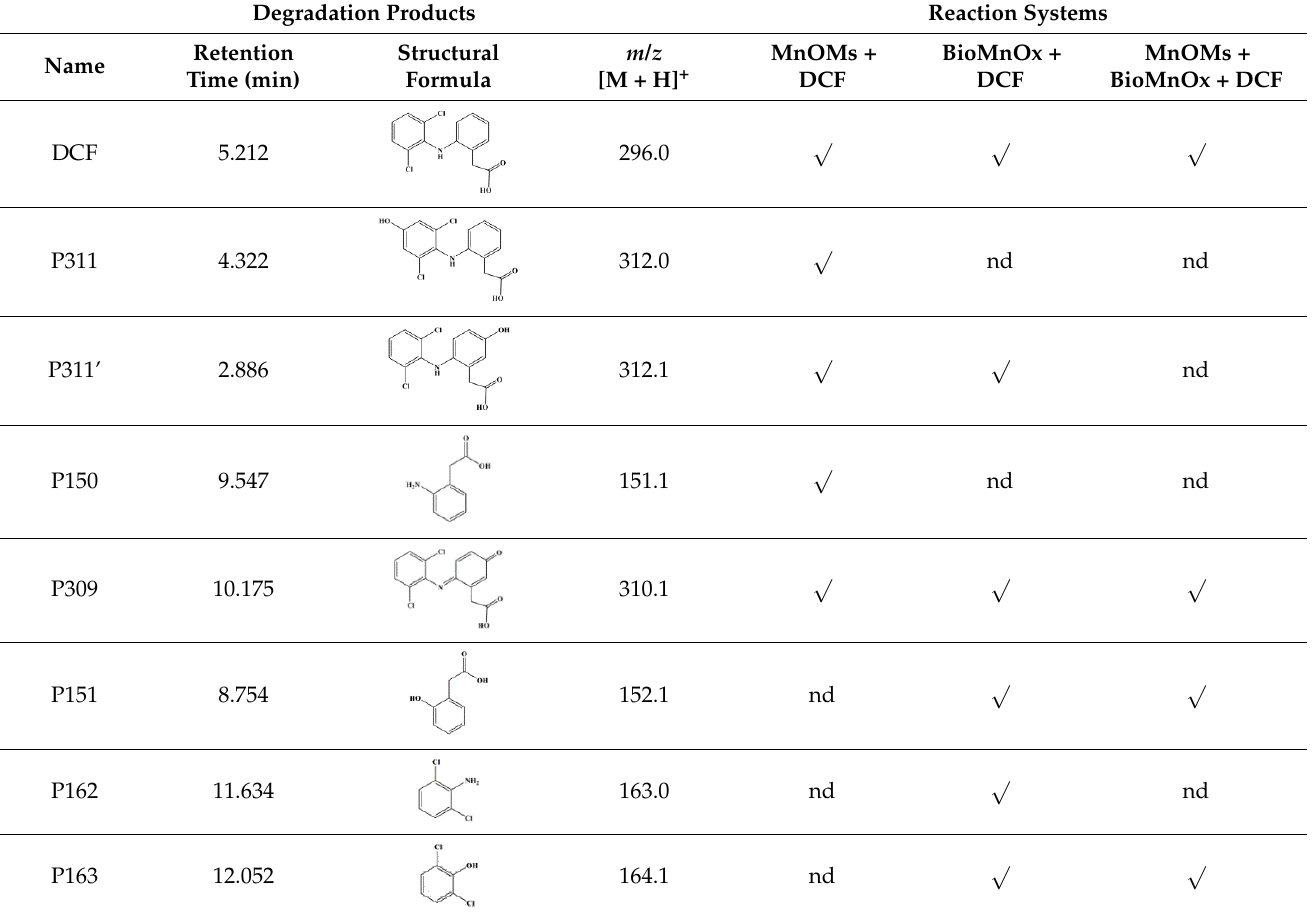
Table 1. Tentative identification of DCF degradation metabolites by microalgae, BioMnOx, and the combined action. Degradation Products